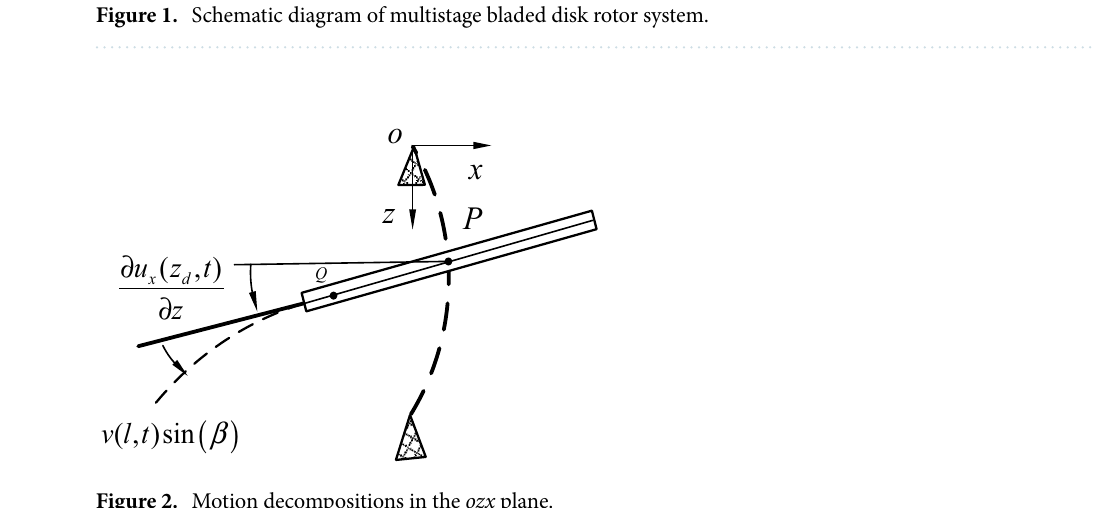
Figure 2. Motion decompositions in the ozx plane.